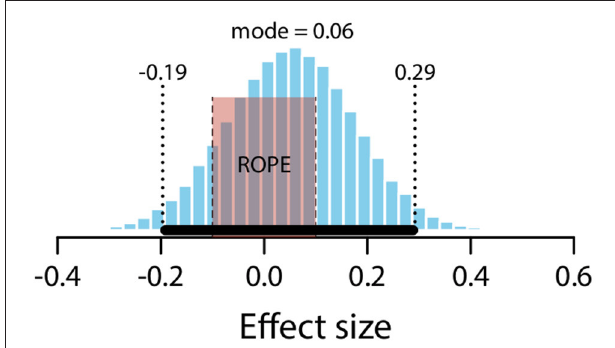
FIGURE 11 | Posterior distribution of effect size for difference between expected and null conditions. ROPE from − 0.1 to 0.1. Black bar represents 95% HDI.